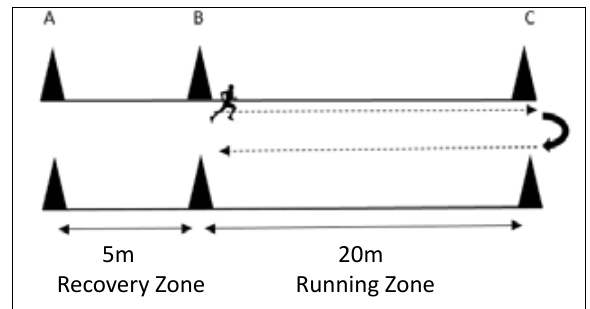
Figure 1. Yo-Yo Intermittent Recovery Level 1 Test